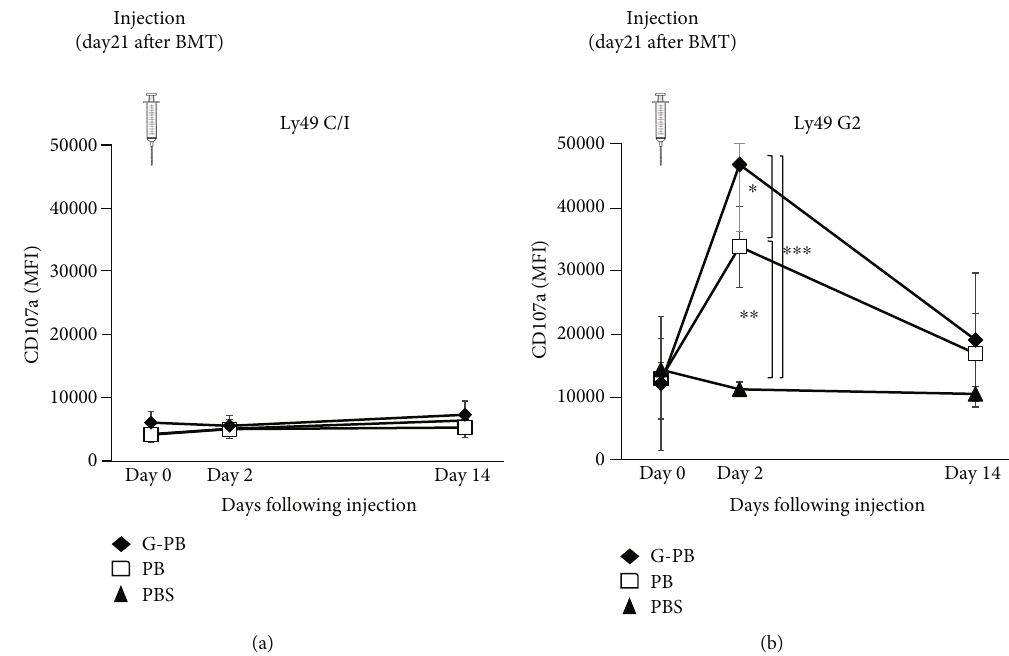
Figure 3: Neutrophils enhance licensed NK cells after BMT. Intraperitoneal injection of PBS ( n = 9 ), PB ( n = 9 ), G-PB ( n = 5) was performed to ehnance licensed NK cell at day21 after BMT. The activation of licensed NK cells by neutrophils was measured using the MFI of CD107a of Ly49C/I + NK cells (a) and Ly49G2 + NK cells (b) before intraperitoneal injection (day 0) and 2 days and 14 days after intraperitoneal injection. ∗ p < 0 : 05, ∗∗ p < 0 : 01, and ∗∗∗ p < 0 : 001 . G-PB: peripheral blood from rmG-CSF-treated mice; PB: peripheral blood from untreated B10 mice; PBS: phosphate-bu ff ered saline.